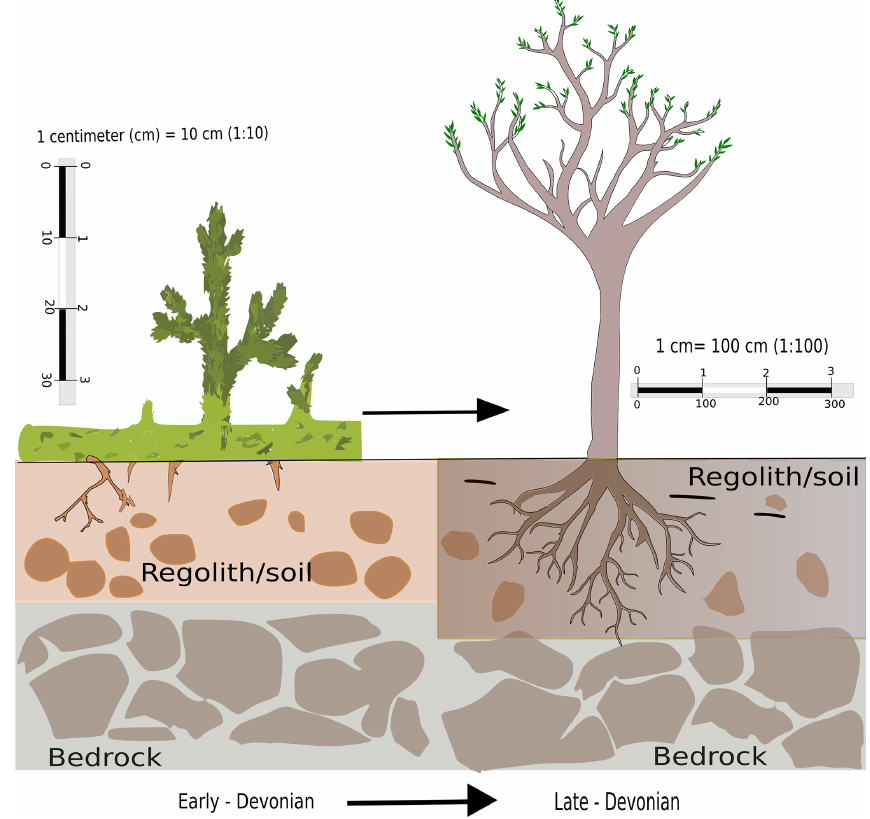
Figure 1. A conceptual diagram of evolution of roots from its earliest stage in the Silurian Period to a sophisticated form during the